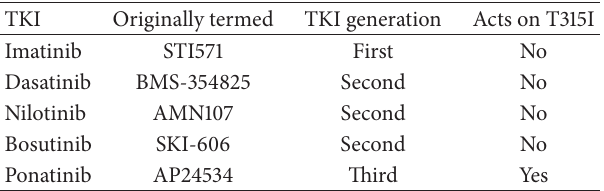
Table 1: Summary of the tyrosine kinase inhibitors and their effects on